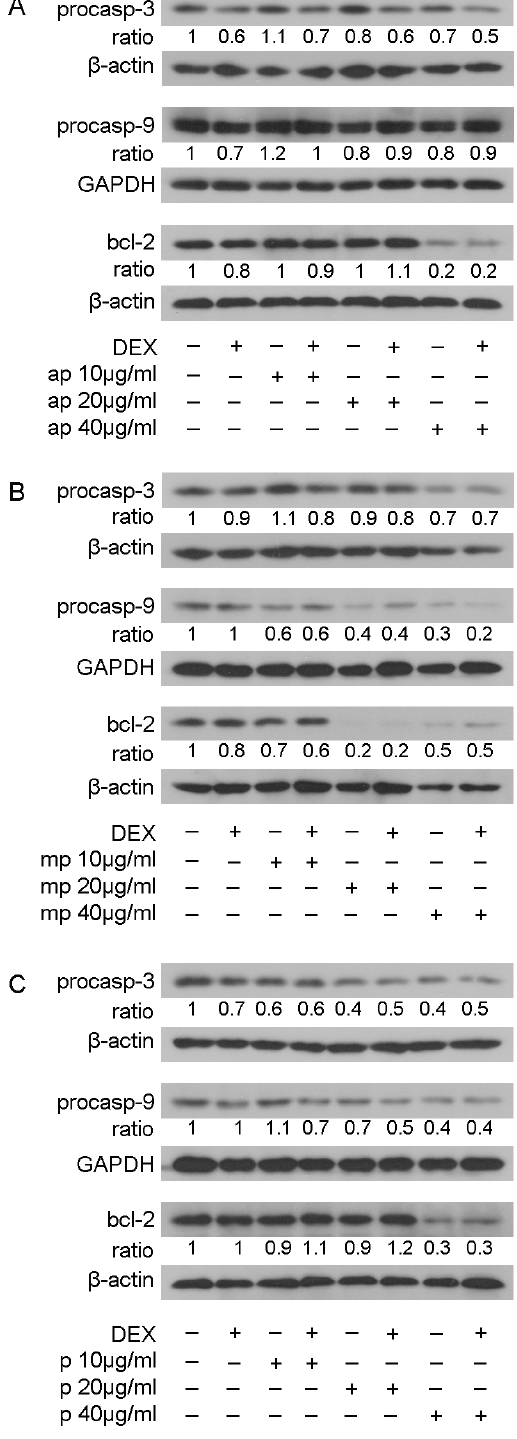
Figure 8. Regulation of procaspase-3, procaspase-9, and bcl-2 protein levels by Chios Mastiha different polarity fractions. Representative images of Western blot analysis of procaspase-3, procaspase-9, bcl-2, GAPDH, and β -actin in HEK293 cell extracts, precultured in hormone-free medium, and subsequently subjected to treatment with 10, 20, and 40 µ g/mL of apolar ( A ), medium-polar ( B ), and polar ( C ) fractions for 48 h. Ratios result from normalization of the apoptosis-related protein bands intensity to the respective bands intensity of β -actin or GAPDH. Relative protein levels in control cells were set as 1.